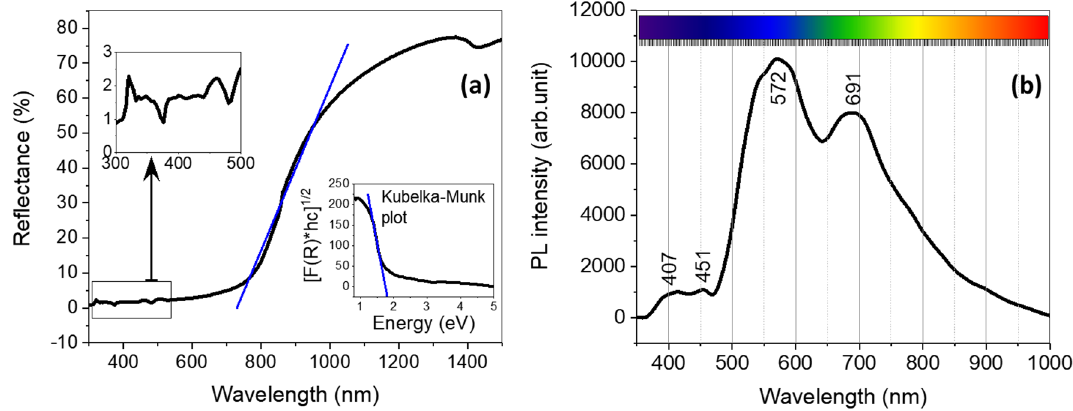
Figure 5. ( a ) UV–Vis spectrum (inset: Kubelka–Munk plot) and ( b ) Photoluminescence analysis for